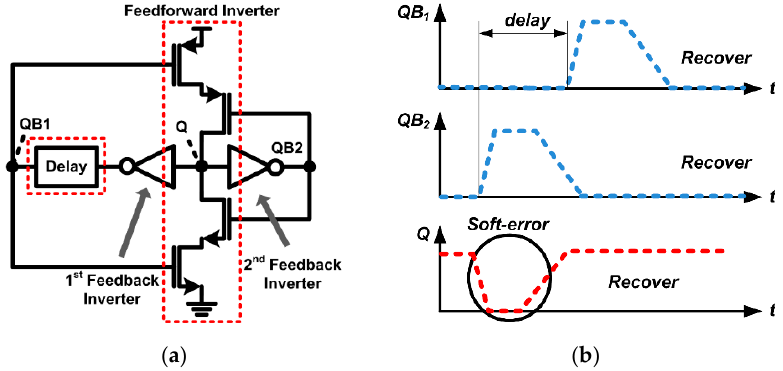
Figure 6. ( a ) Proposed radiation-hardened latch with delay-based dual feedback loops, ( b ) Timing diagram when the soft error occurs.